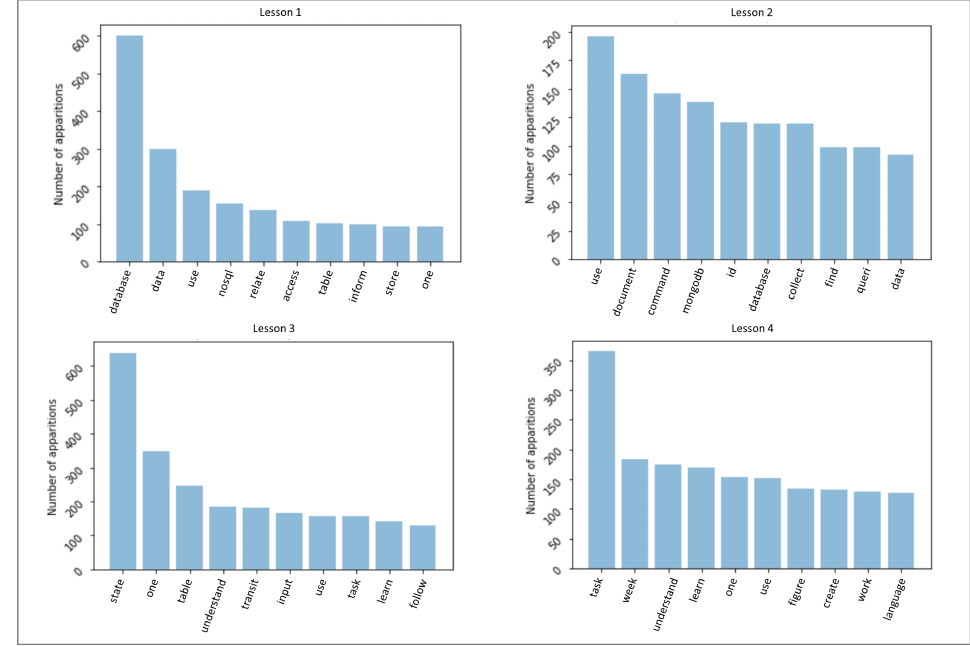
Figure 5. Top 10 most frequent words in each lesson.